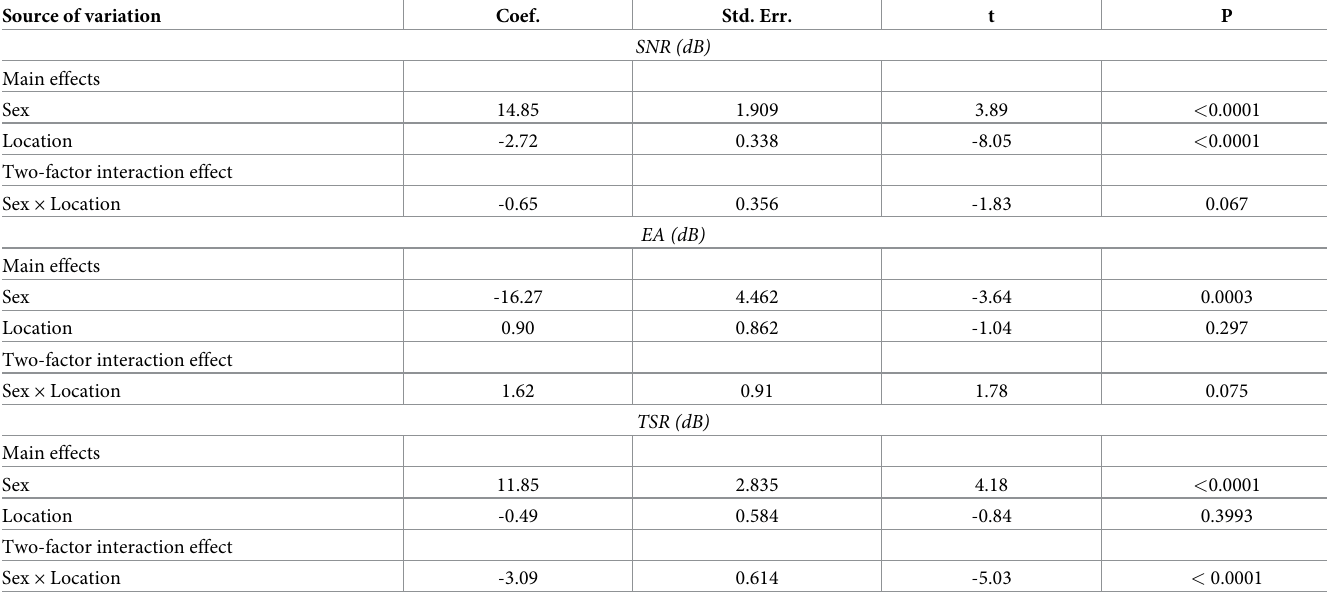
Table 5. Result of the general linear mixed models for signal-to-noise ratio (SNR), excess attenuation (EA), tail to signal ration (TSR) of propagated songs of the Yellow-breasted Boubou ( Laniarius atroflavus ). Main and two-factor interaction effects are presented for the following source of variation: sex (male, female), location (transmissions STREAM FROM and STREAM TO). Both transects were done on a distance of 25 m only, close to the stream noise and with opposite location of loud- speaker and microphone in each transmission. Source of variation Coef. Std. Err. t P SNR